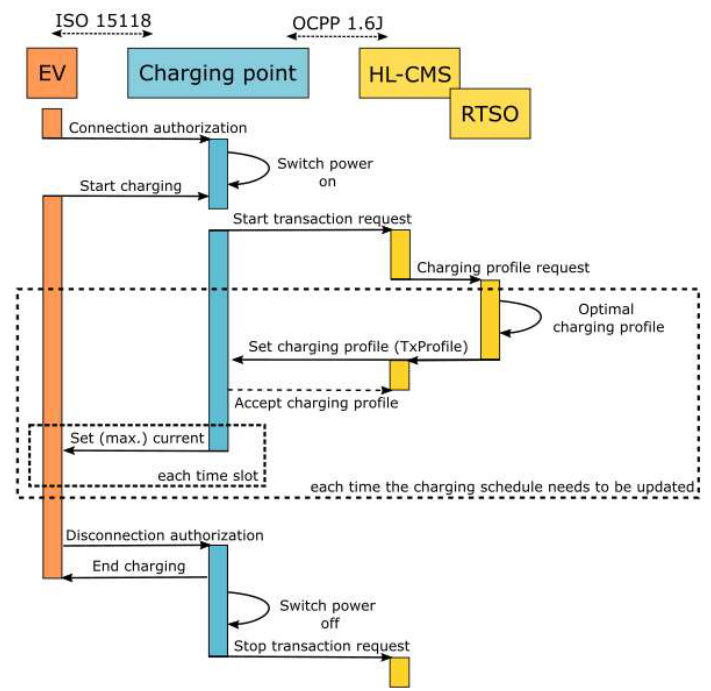
Figure 7. Sequence of the OCPP communication protocol between the EV, the charging point and the HL-CMS.